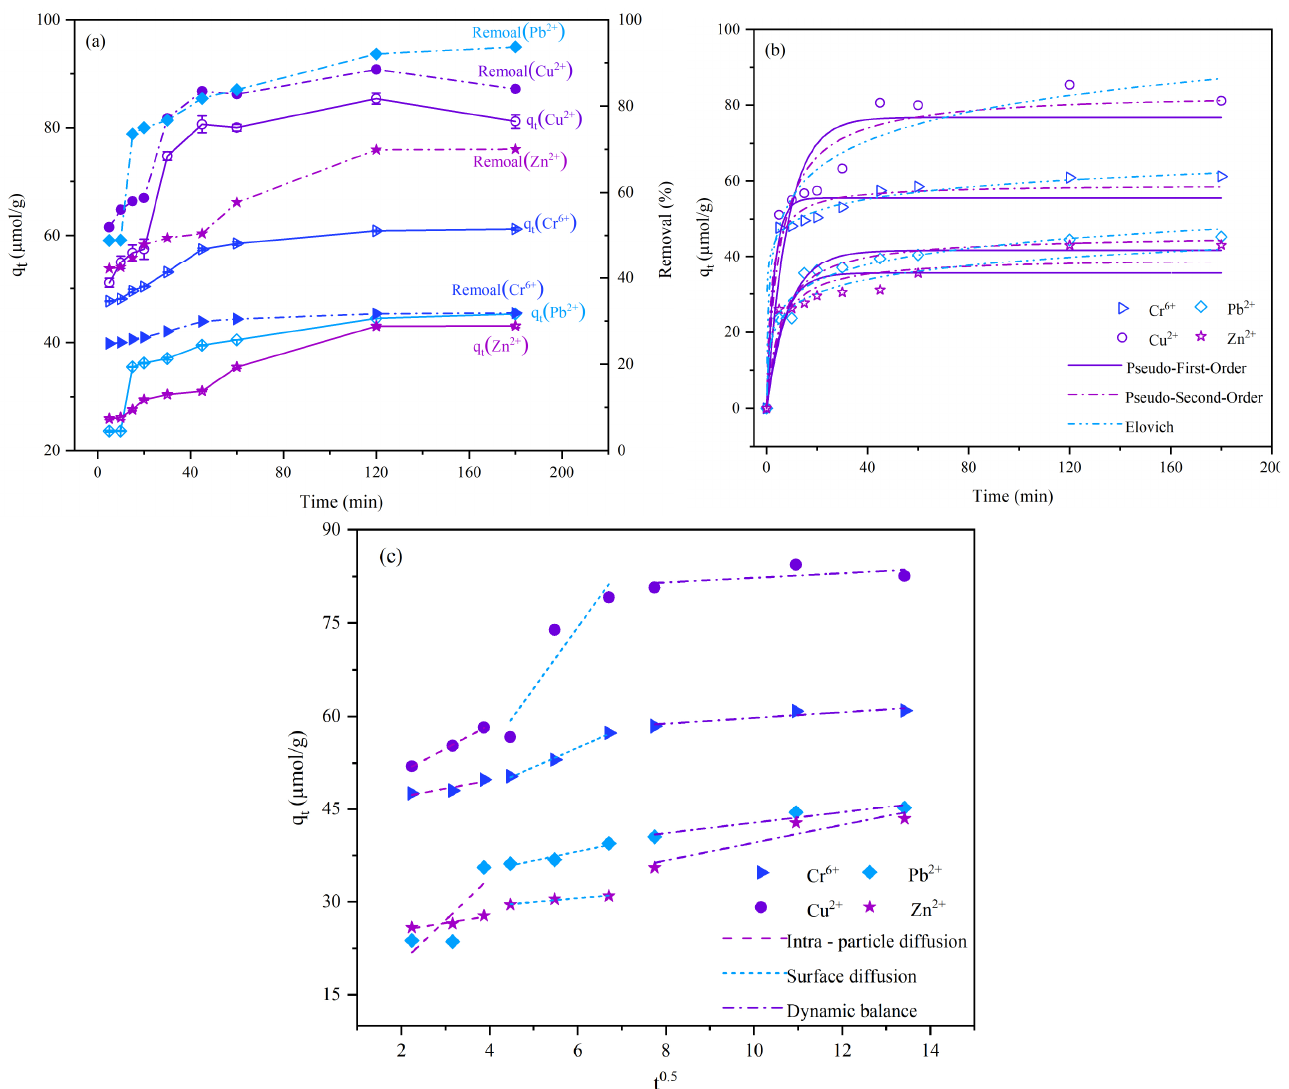
Figure 2. ( a ) Adsorption kinetics of Cr 6+ , Cu 2+ , Pb 2+ , and Zn 2+ onto magnetic nano-chitosan in aqueous solution; ( b ) fitting by pseudo-first-order, pseudo-second-order, and Elovich kinetic models; and ( c ) fitting of intraparticle diffusion kinetic model.